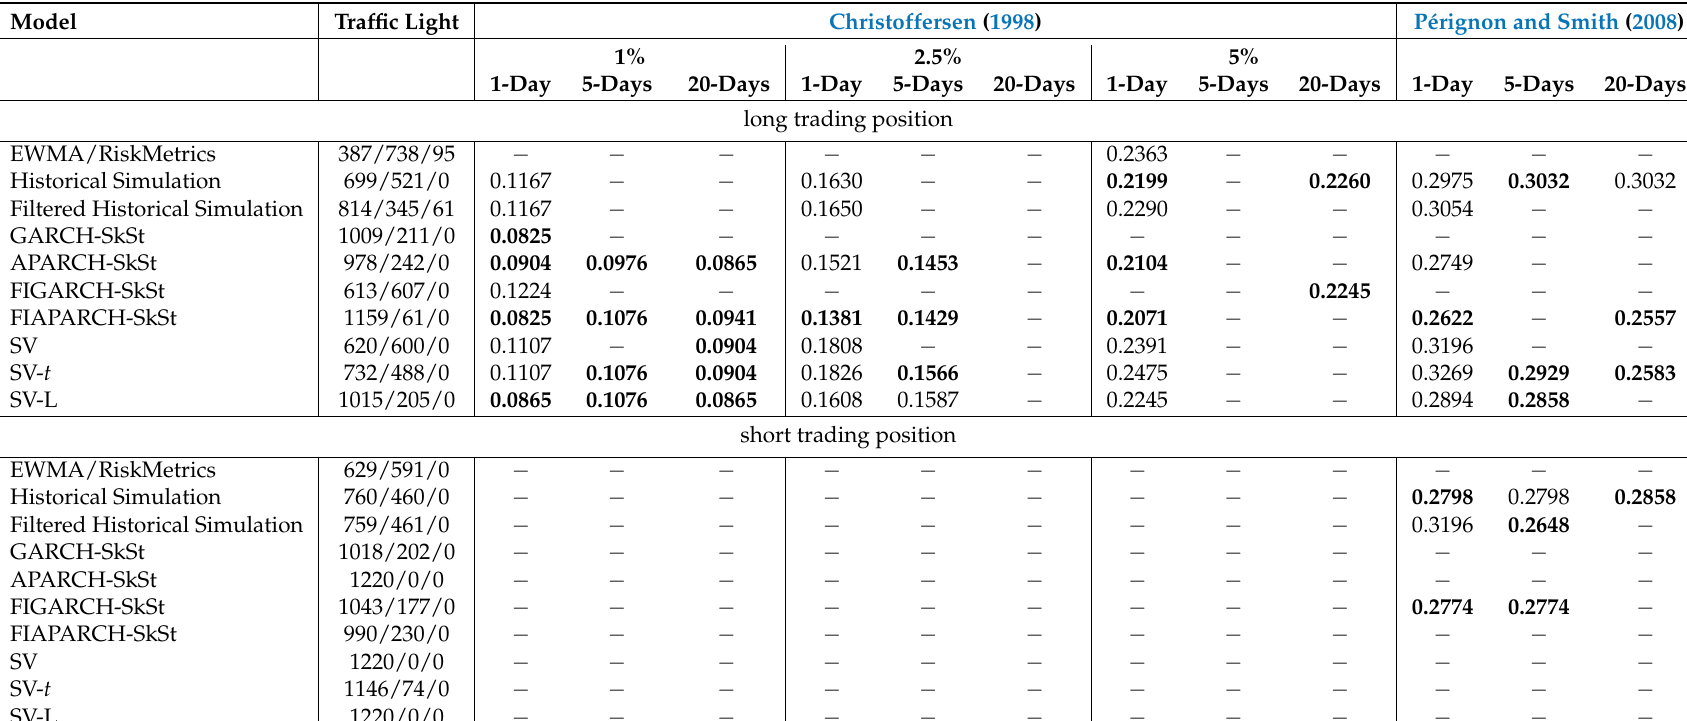
Table 5. Value-at-Risk backtest results for SET